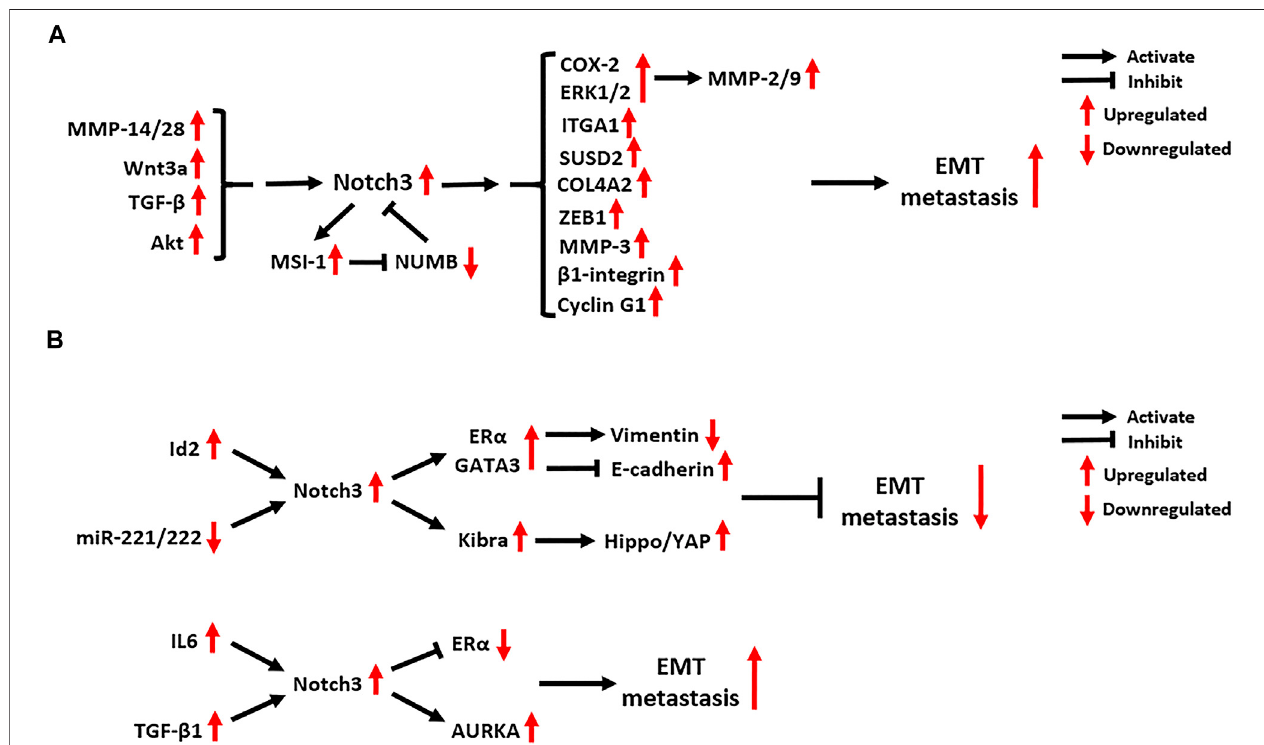
FIGURE 6 | Notch3-related EMT molecular mechanisms in (A) tumors other than breast carcinoma and (B) breast carcinoma. EMT: Epithelial-Mesenchymal Transition; MMP: Matrix Metalloproteinase; Wnt3a: Wnt Family Member 3A; TGF- β : Transforming Growth Factor Beta; MSI-1: Musashi RNA Binding Protein 1; NUMB: NUMB Endocytic Adaptor Protein; COX-2: Cyclooxygenase 2; ERK1/2: Extracellular-regulated Kinase 1/2; ITGA1: Integrin Subunit Alpha 1; SUSD2: Sushi Domain Containing2;COL4A2:CollagenTypeIVAlpha2Chain;ZEB1:ZincFingerE-BoxBindingHomeobox1;Id2:InhibitorOfDNABinding2;ER α :EstrogenReceptor α ; GATA3: GATA Binding Protein 3; IL6: Interleukin 6; KIBRA: KIdney and BRAin; AURKA: Aurora Kinase